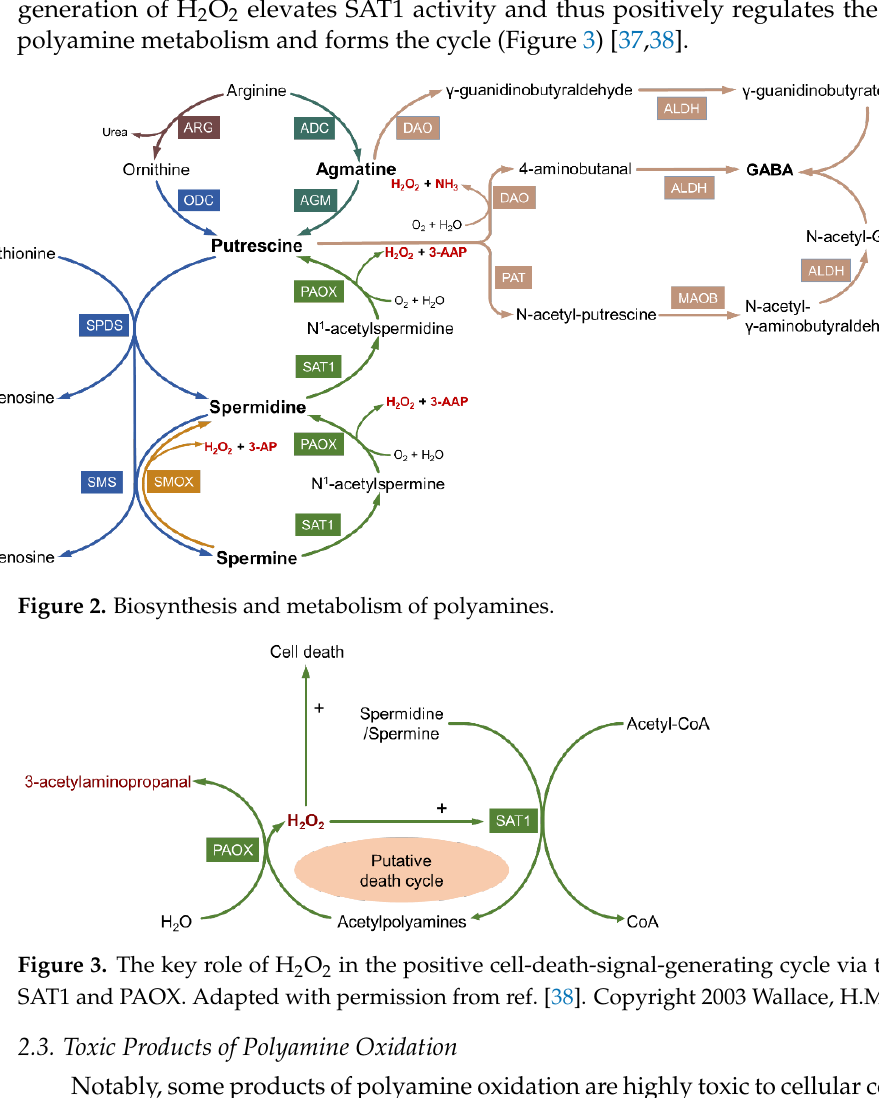
Figure 3. The key role of H 2 O 2 in the positive cell-death-signal-generating cycle via the action of SAT1 and PAOX. Adapted with permission from ref. [38]. Copyright 2003 Wallace, H.M.